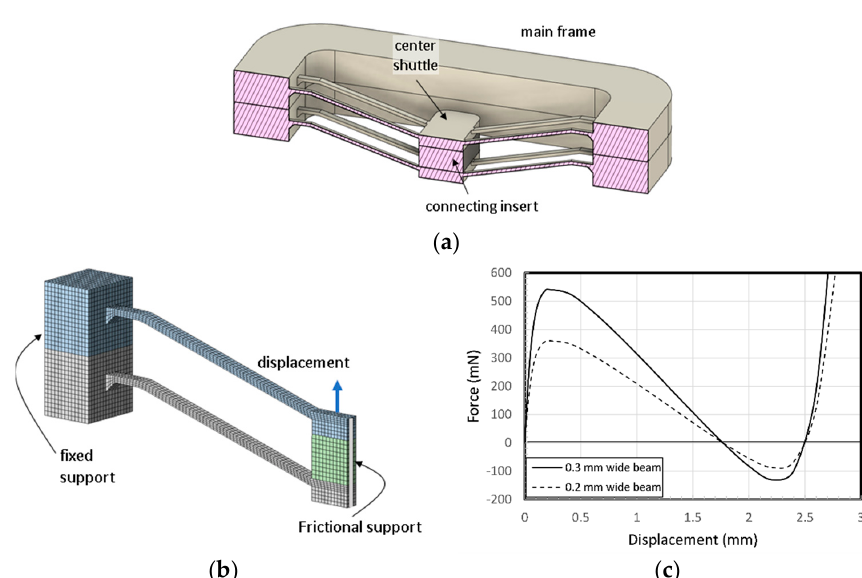
Figure 4. OBM based on V-beam structure stacking: ( a ) 3D sectional view; ( b ) FE model with boundary conditions; ( c ) simulated static force-displacement curves.